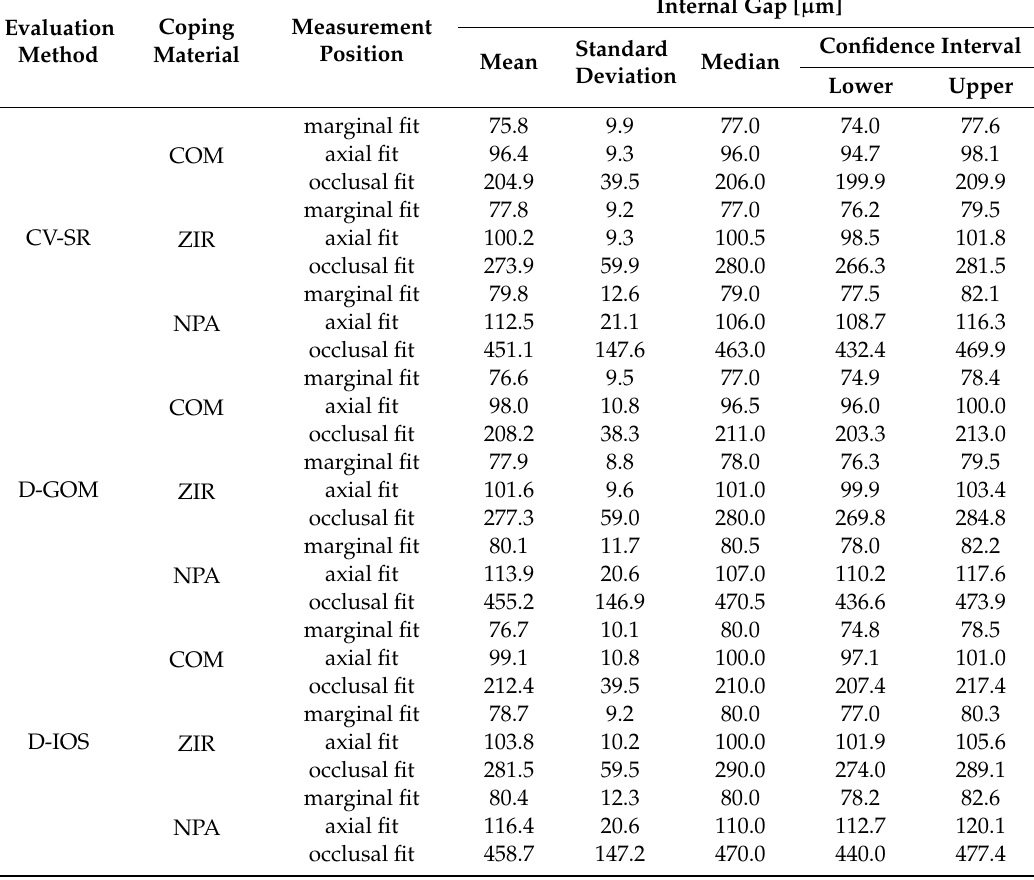
Table 2. Descriptive statistics of the internal gap [ µ m] for the three evaluation methods (CV-SR, D-GOM and D-IOS), coping material (COM = resin composite, ZIR = zirconium dioxide and NPA = non-precious alloy) and measurement position (marginal, axial and occlusal fit).